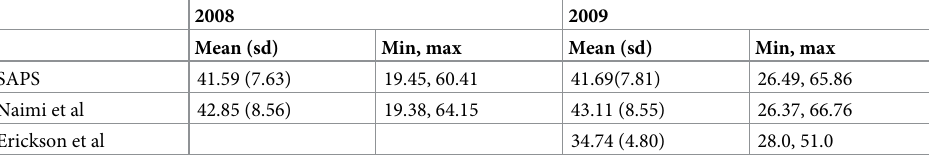
Table 2. Descriptive means and distribution of SAPS, the APS (Naimi et al 2014), 2008 and 2009 and Erickson et al’s scores